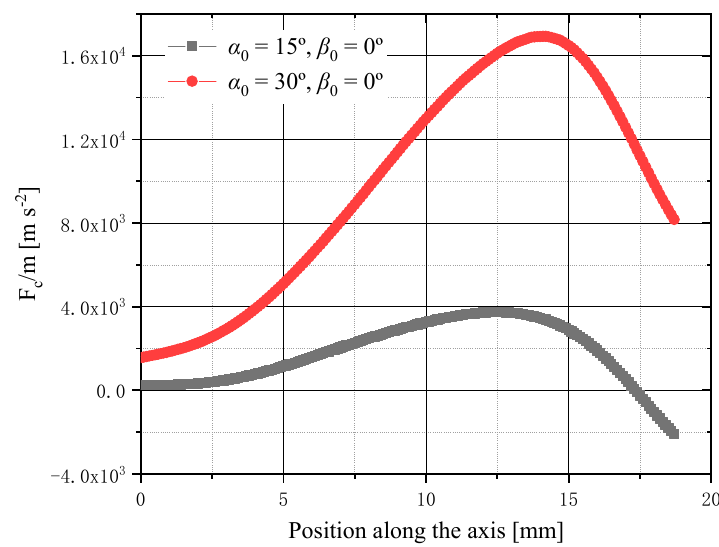
Figure 22. Coriolis forces per unit mass along the axial position at 3000 r/min.